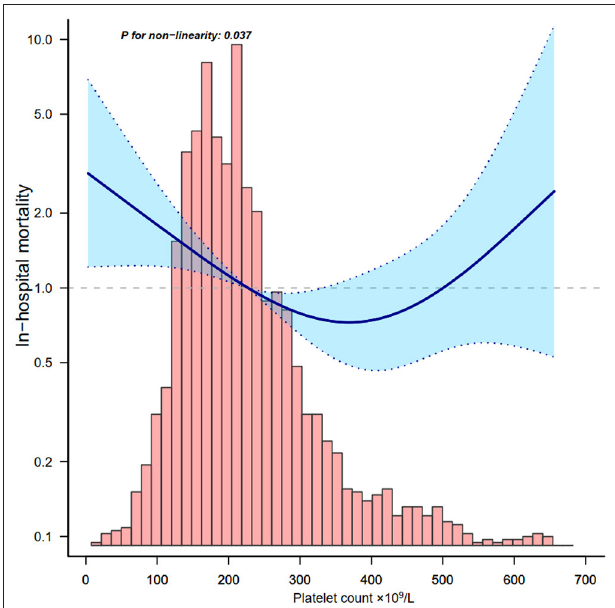
FIGURE 2 | Relationship between platelet count and in-hospital mortality. Adjusted for all covariates in Table 2 .